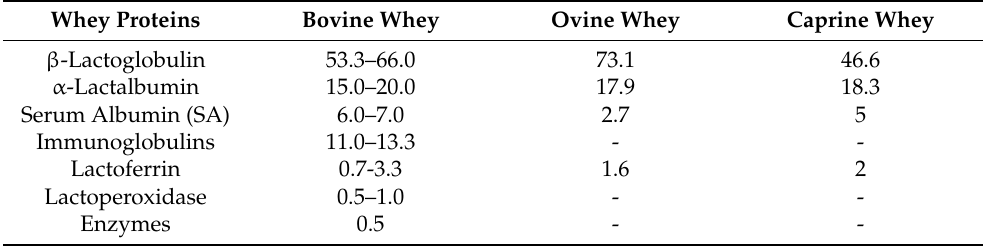
Table 2. Relative proportions of bovine, ovine and caprine whey proteins in whey